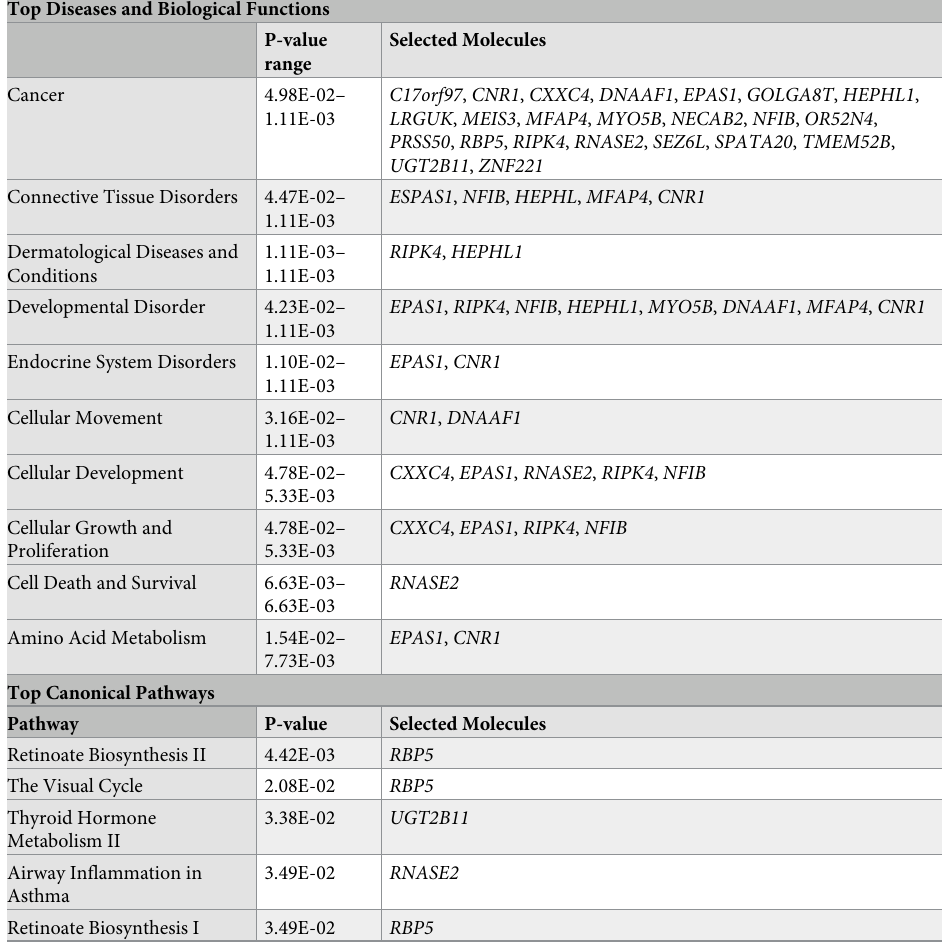
Table 8. Enrichment analysis of genes associated with COVID-19 severity (all